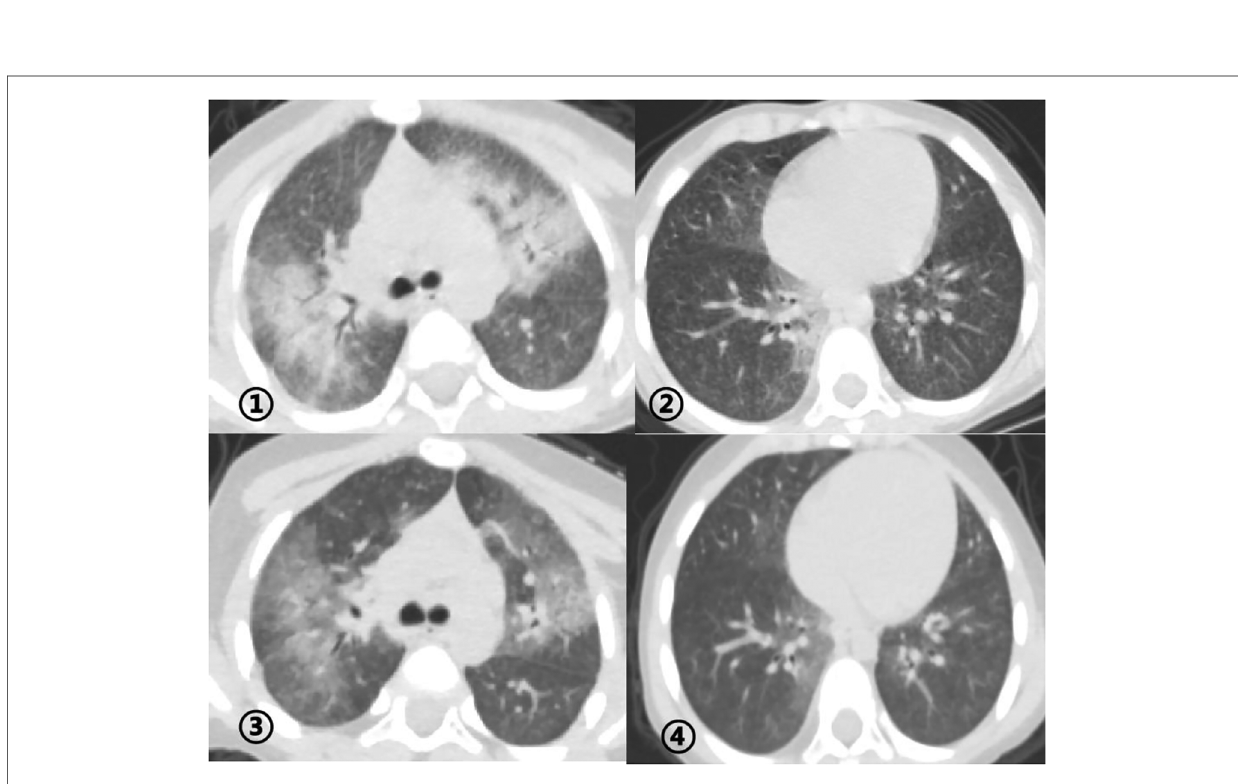
FIGURE 3 ①② : Chest CT before the treatment at the age of 25-months old revealing ground glass opacities (GGO) and consolidations in both lungs. ③④ : Chest CT at the age of 29-months old revealing signi fi cant absorption of GGO and consolidations in the lung after treatment for 4